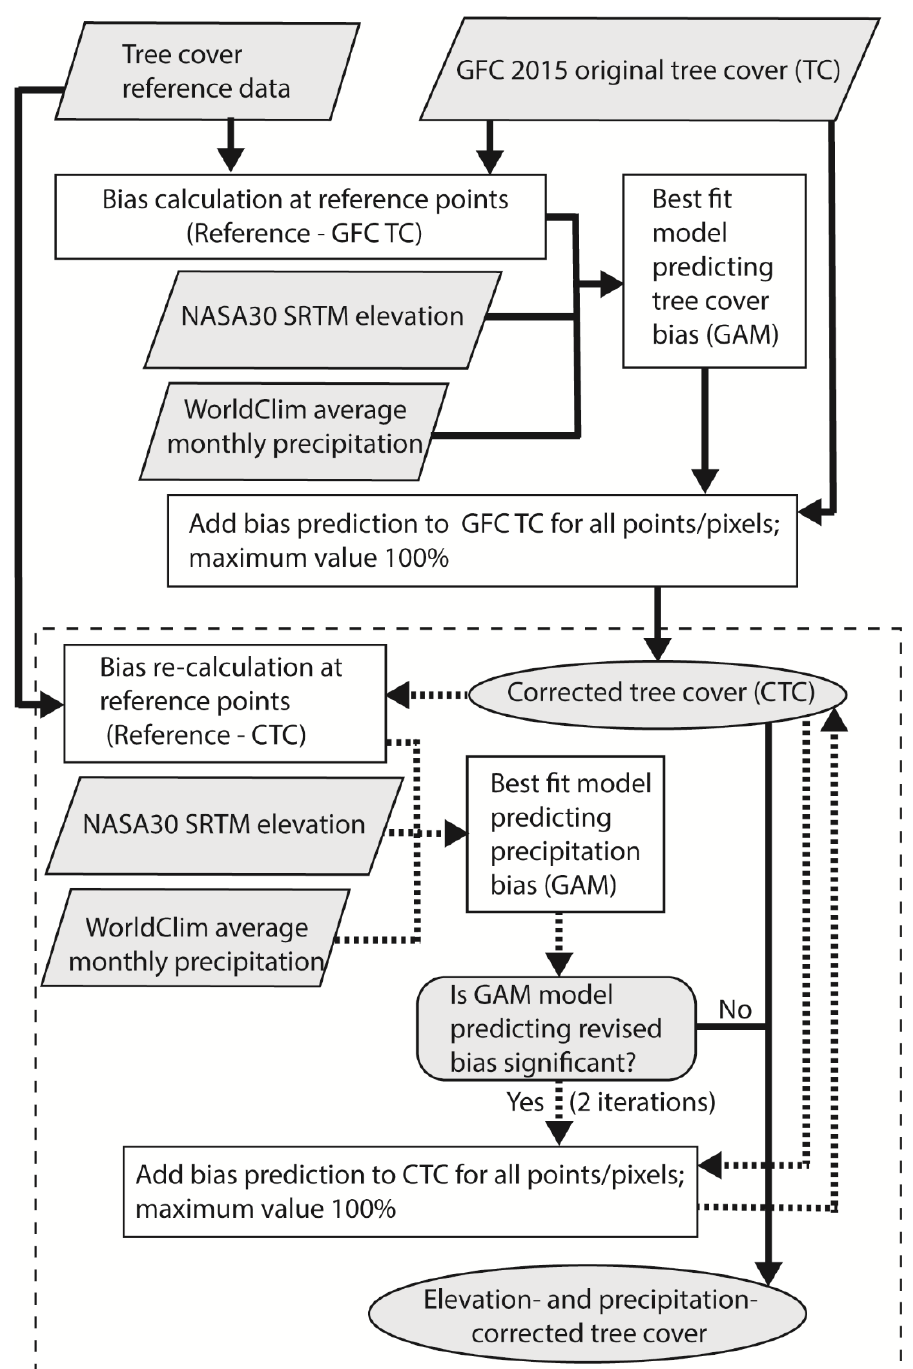
Figure 1. Workflow for tree cover bias prediction and correction. The top section shows the initial correction for elevation and precipitation (one iteration), while the dashed box highlights the iterative bias correction (two additional iterations). The black lines indicate processes done once, while the dotted arrows indicate processes done more than once. The parallelograms show inputs, the boxes show workflow intermediate steps, the rounded gray boxes show questions that control the workflow (with labeled answers adjacent), and the gray ovals indicate final workflow products.